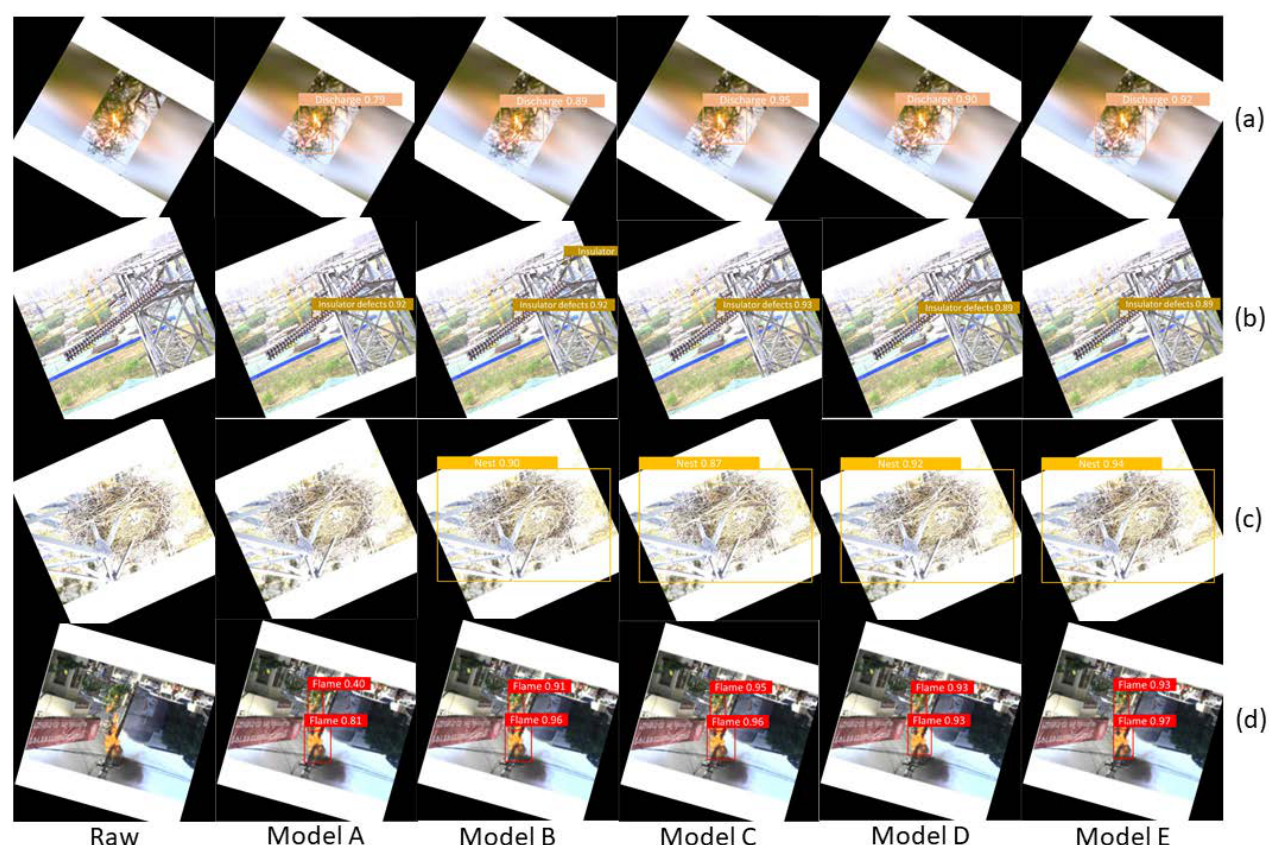
Figure 10. The test performance results of the experimental model in this paper are under different complex conditions. ( a ) under the condition that the target features are very similar; ( b ) under the condition of similar background features; ( c ) under the condition of enhanced illumination and price adjustment; ( d ) under the condition of a small target.